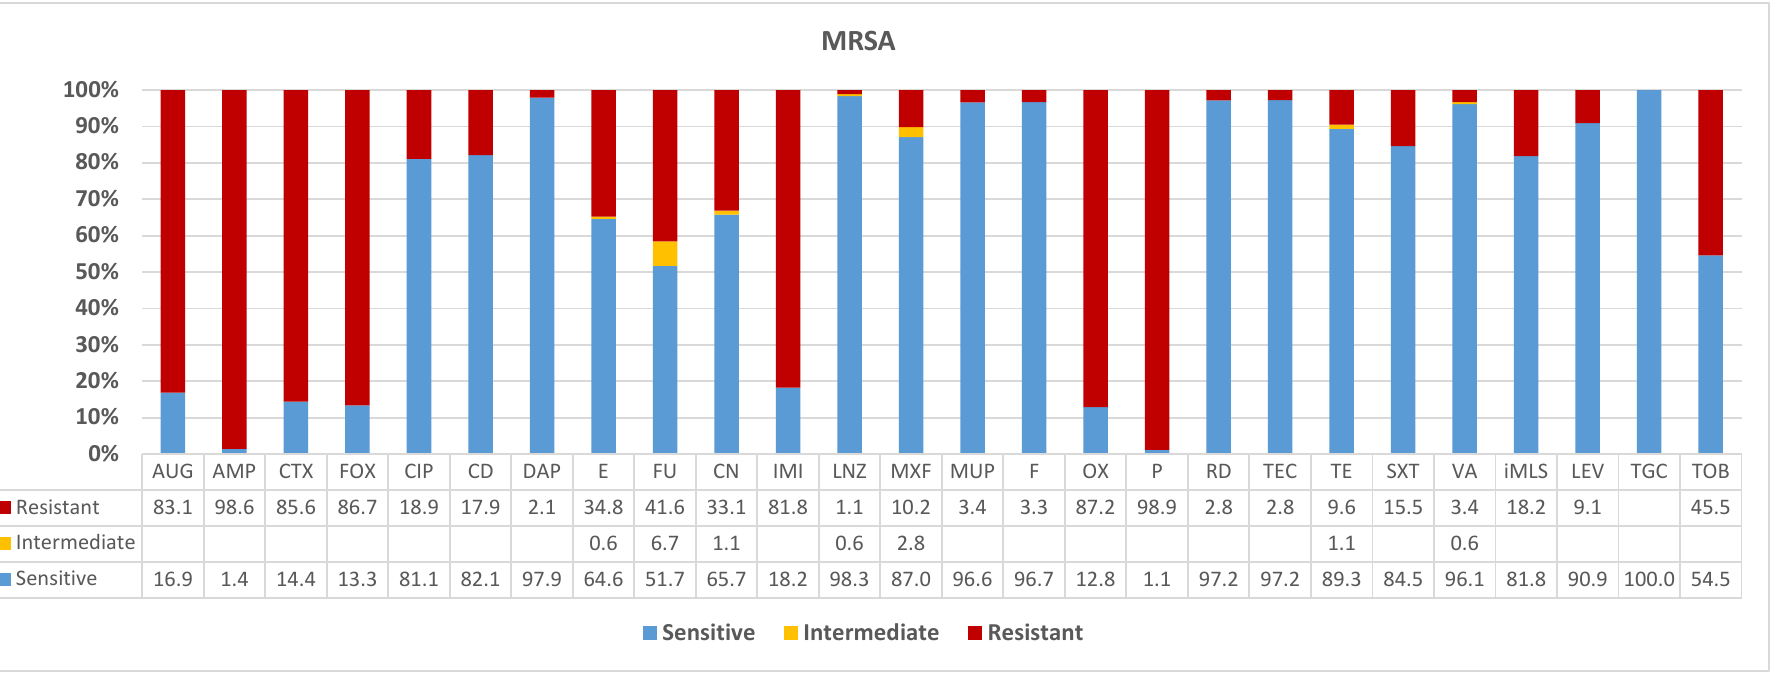
Figure 1. Antibiogram patterns of methicillin-resistant Staphylococcus aureus isolates recovered from clinical specimens in Ha’il region, Saudi Arabia. AUG—